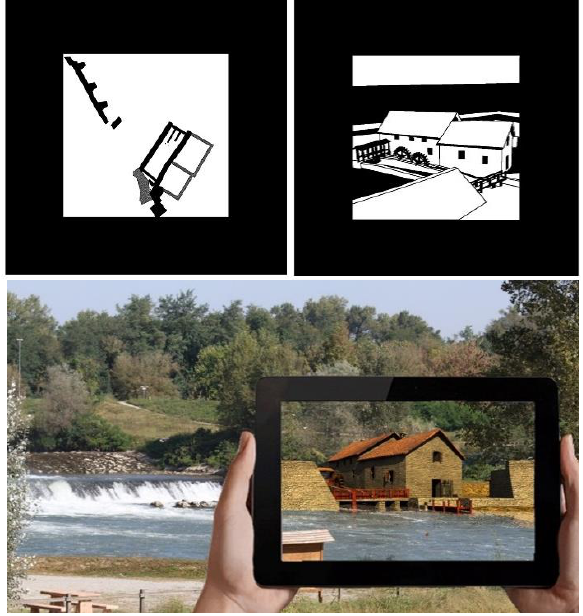
Figure 11. Above: two custom markers for the rendering of the 3D reconstruction visible and navigable in AR. Below: on site use of AR system.